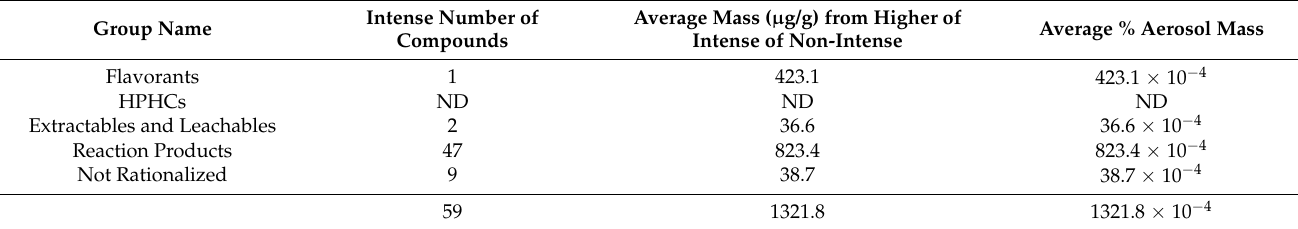
Figure 6. Comparison of the Compounds Detected in VT5 Aerosol to Compounds Found in Smoke of Combustible Ciga- rette (Circles are to Scale). Table 12. Compounds Exclusive to JUUL VT5 Aerosol Compared to Cigarette Smoke. Table 12. Compounds Exclusive to JUUL VT5 Aerosol Compared to Cigarette